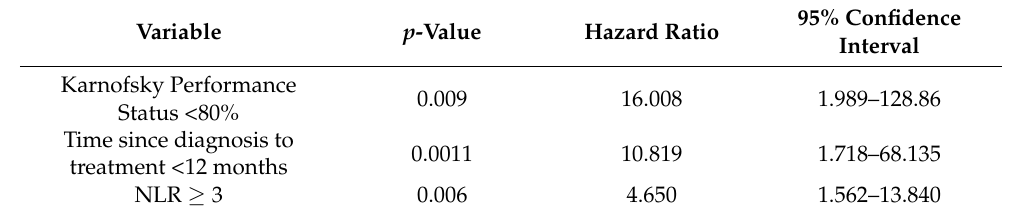
Table 3. Multivariate analysis.